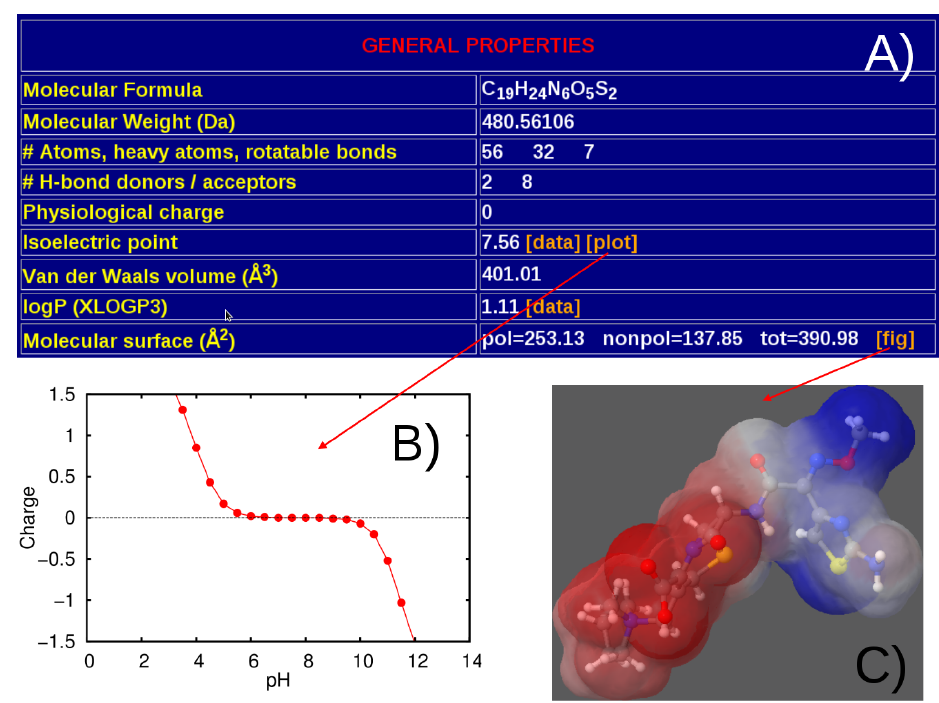
Figure 3. Snapshots of the general properties available for each compound ( A ); the molecular net charge dependence on pH computed with MarvinSketch [30] ( B ); and the polar/non-polar (red-white-blue color scale) molecular surfaces evaluated with the PLATINUM server [52] ( C